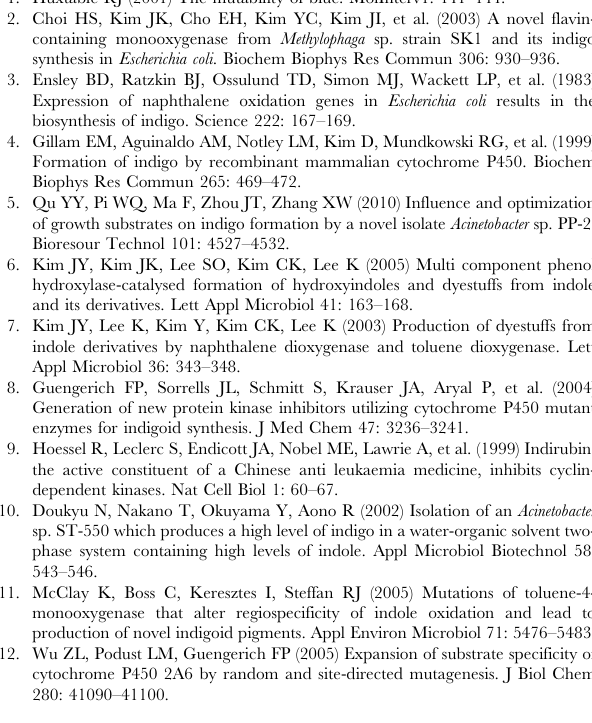
Table S1 Amino acid identity between PH W1 and other binuclear iron hydroxylases. Table S2 Production of dyestuffs from indole deriva- tives by Escherichia coli expressing different oxygenas-